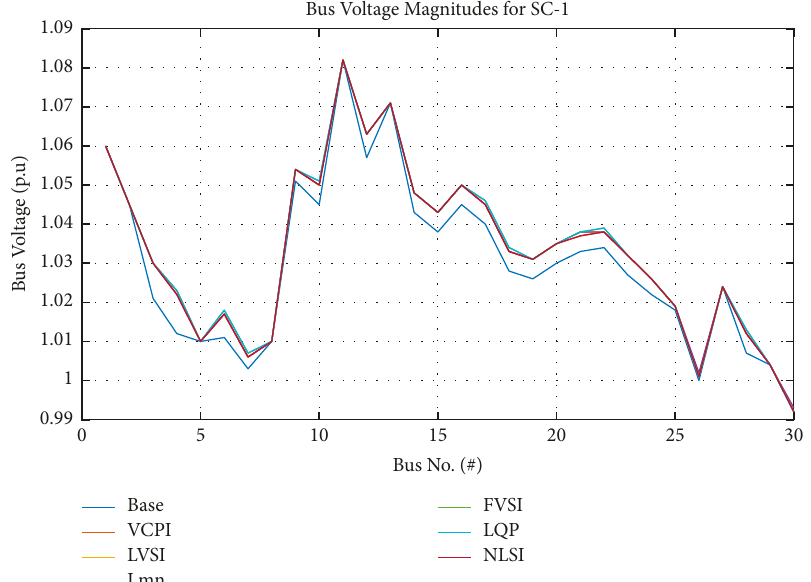
Figure 11: SC-1 bus voltage magnitudes for the different case studies. Bus Voltage Magnitudes for SC-2